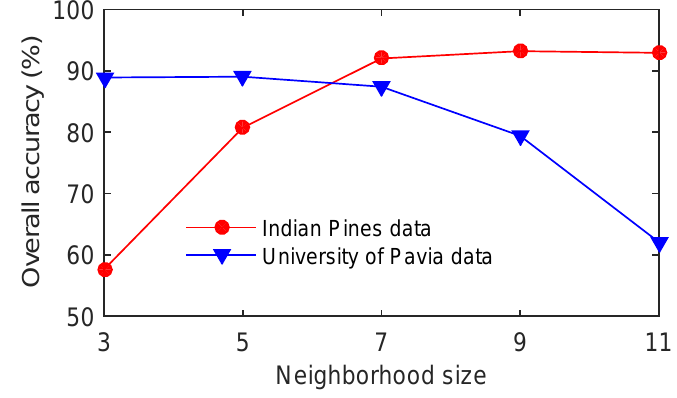
Figure 7. The effect of C ( C ∈ { 1,2, . . . ,100 } with γ = 1) on OA of SVM for the Indian Pines data.